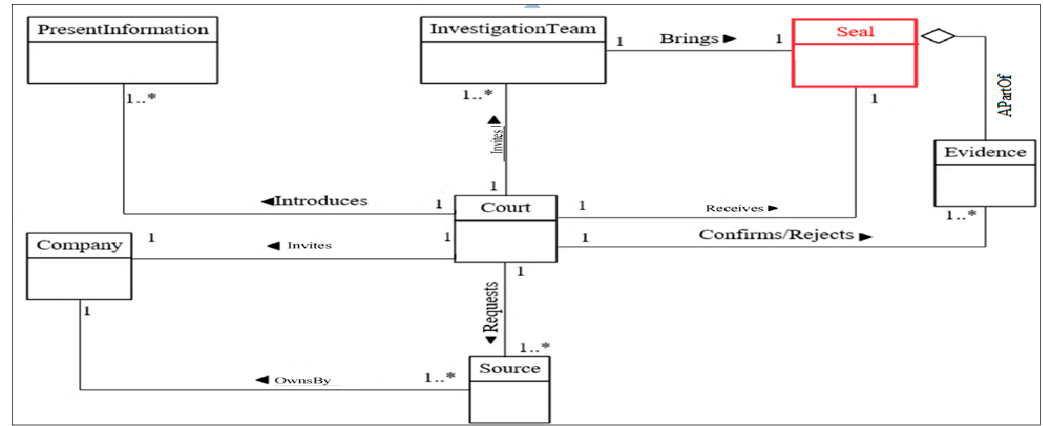
Figure 9. Validated DBFIM Documentation and Presentation Class 4.